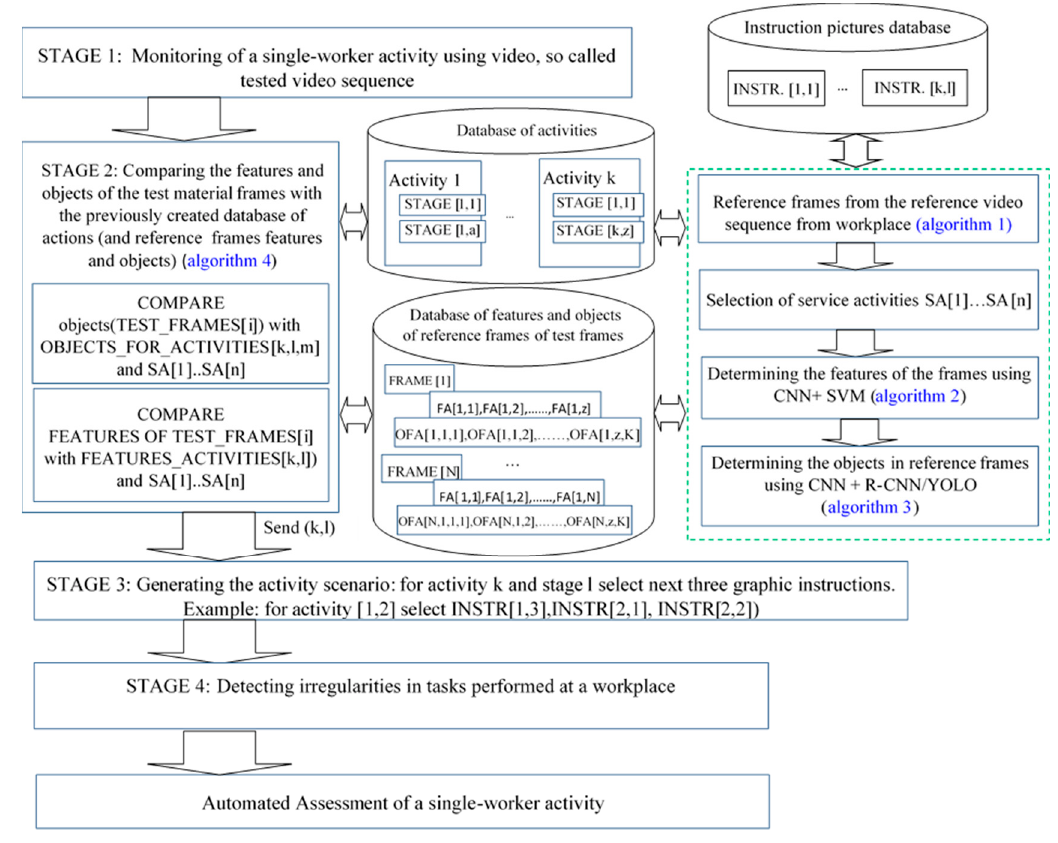
Figure 1. A model for automatically assessing the activity of a single worker, displayed on the basis of the stage of activities identified. Here i —number of test frames, i ϵ N, k —number of servicing procedures stage, k ϵ N, l —number of stages in a single activity, l ϵ N; m —number of objects in the frame, m ϵ N; TEST_FRAMES—an array storing frames of the video material analysed; FEATURES_ACTIVITIES—jagged array containing the features of the reference frames; OBJECTS_FOR_ACTIVITIES—a jagged array containing object labels for each activity and reference frame; ACTIVITIES—a jagged array storing information of activities and stages of activity; STAGE—activity stage, for example STAGE [1,2] means activity 1 and stage 2; ACTIVITY—servicing procedure